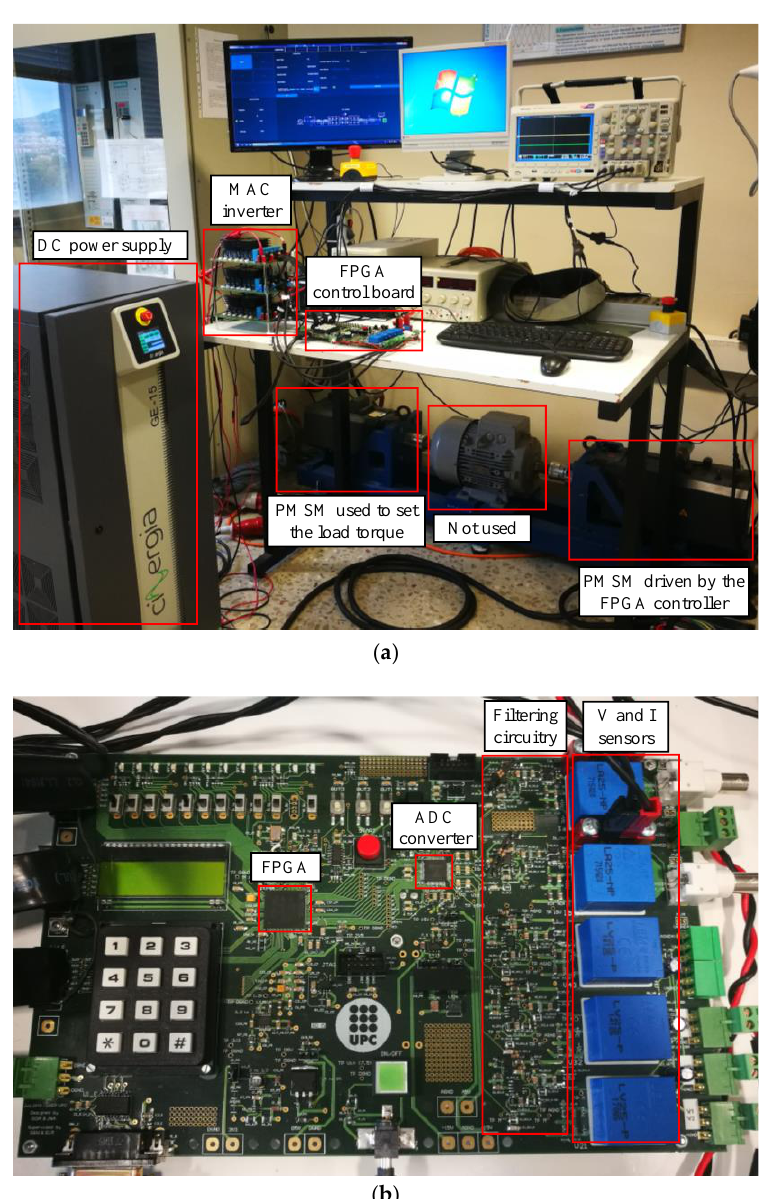
Figure 6. Experimental testbed. ( a ) Overview of the system; ( b ) FPGA control board. The four-level three-phase MAC inverter employs 200 V STP20NF20 MOSFET devices (ST microelectronics, Amsterdam, Netherlands). The reference of the PMSM driven by the FPGA controller is 1FT6105-8SB71-2AA0 (Siemens, Berlin, Germany). This motor is a surface-magnet type PMSM, with a nominal speed of 1500 rpm and a nominal torque of 59 Nm, thus, a nominal power of 9.27